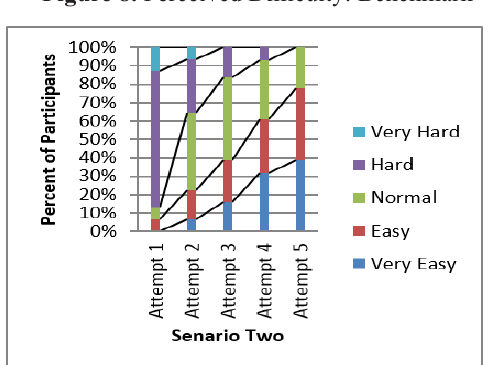
Figure 9. Perceived difficulty: Scenario two